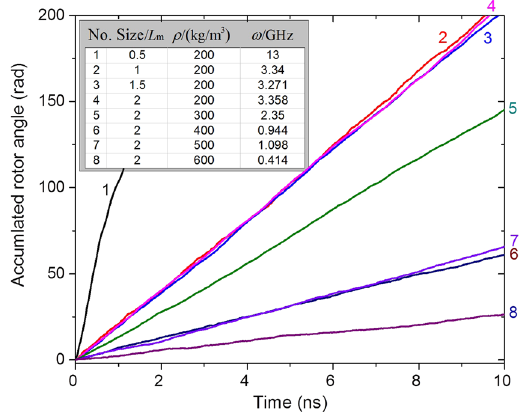
Figure 11. Histories of the accumulated rotor angles in the same boxes ( l = 8) with different argon